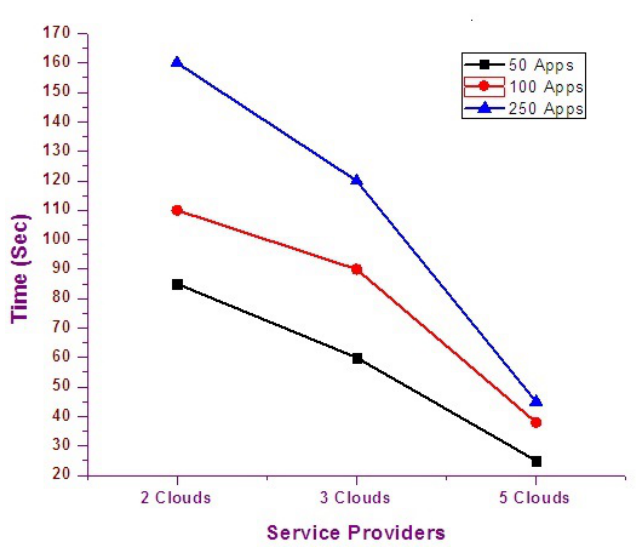
Figure 11. Variation of (PT) in Different Environment.